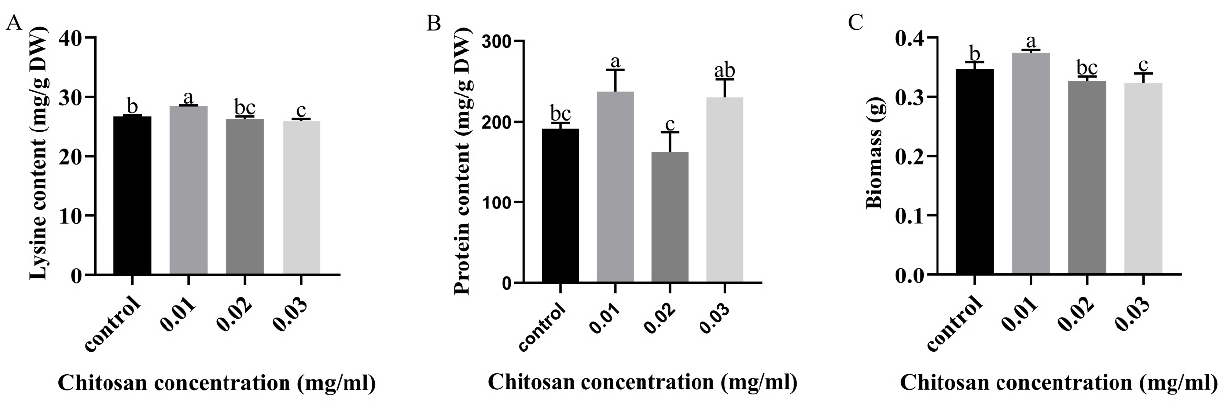
Figure 1. Effects of chitosan on ( A ) lysine, ( B ) protein and ( C ) biomass of F. filiformis mycelium. All calculated results are expressed as mean ± standard deviation, and different English letters indicate significant differences among different treatments ( p < 0.05).